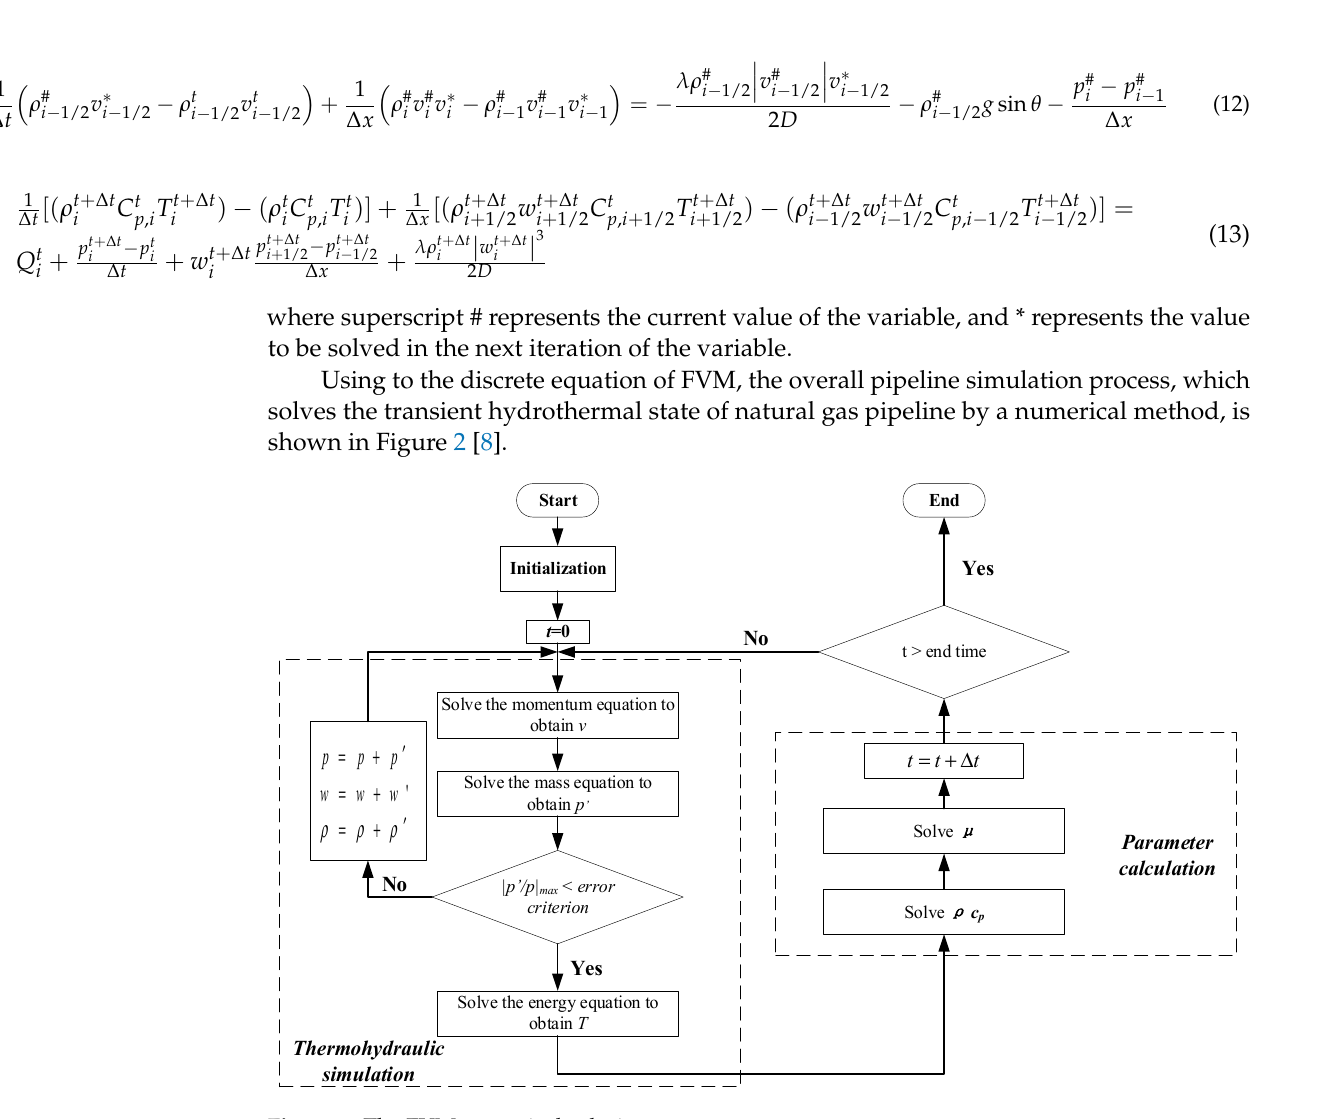
Figure 2. The FVM numerical solution process.